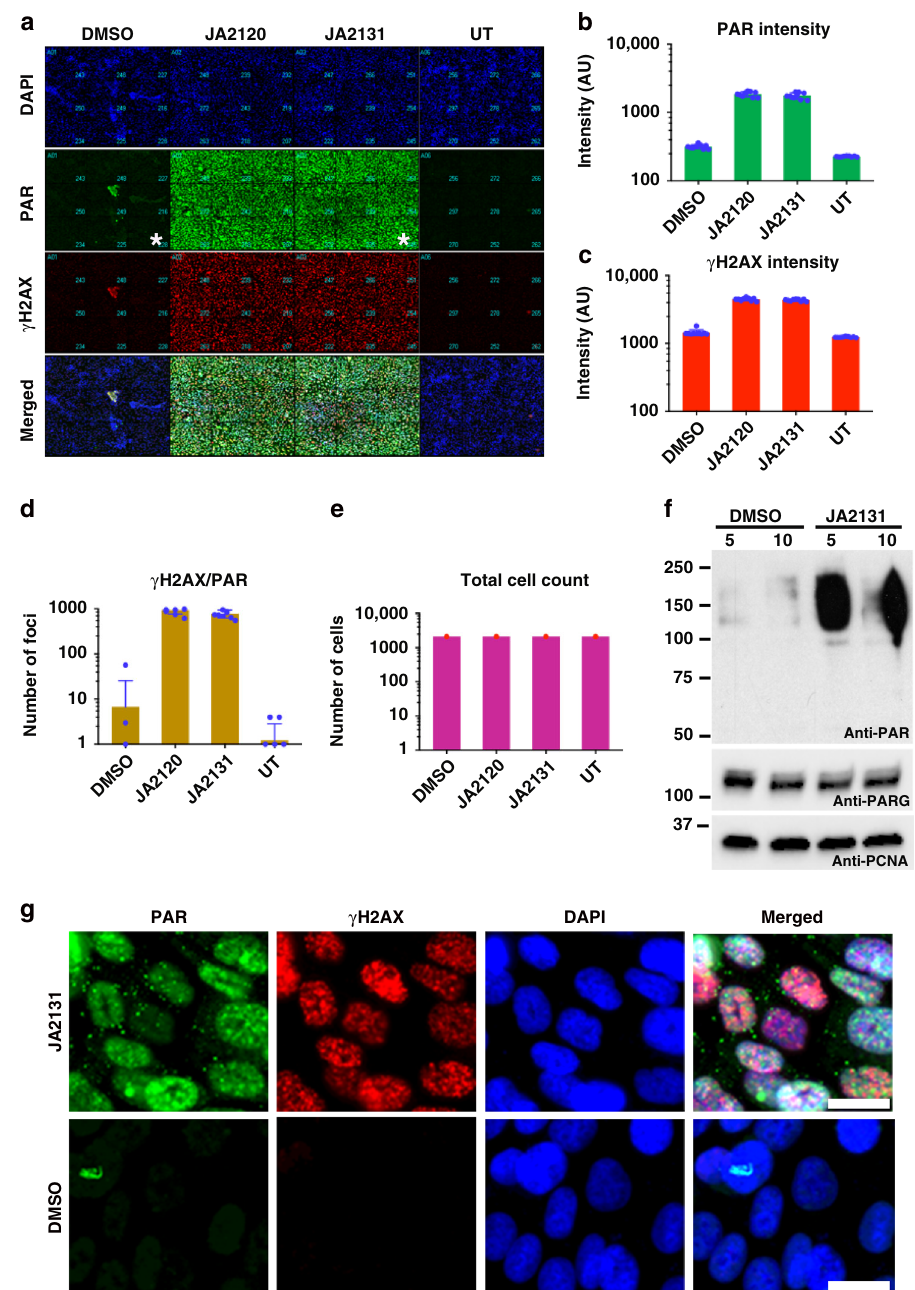
Fig. 5 PARGi sensitizes cells to IR damage. a High level of PAR accumulation and γ H2AX foci formation in cells exposed to PARGi. PC3 cells treated with DMSO or PARG inhibitors (JA2120 or JA2131) for 2h, irradiated with 7Gy, recovered for 1h were fi xed and immuno-stained with Poly(ADP)-Ribose (PAR, green) and γ H2AX (red) antibodies, nucleus stained with Hoechst (blue). Cells were analyzed with quantitative high-content imaging ( b – e ). Quantitative analysis of PAR intensity ( b ), γ H2AX intensities ( c ), the number of cells showing PAR / γ H2AX co-localizations ( d ), and nucleus count for the total number of cells analyzed for each group ( e ). f Immunoblotting of PARGi JA2131-treated PC3 cells showing inhibitor-induced cellular PARylation. Cells were treated with JA2131 for 2h followed by 7Gy IR, then allowed to recover for 1h before lysis. Total cell lysates were immunoblotted with anti-PAR (upper panel) followed by anti-PARG (middle panel) and Anti-PCNA (lower panel) as loading controls. g Enlarged, individual, representative images taken from one quadrant of the 3×(3×3) square shown in a and the region marked with an asterisk. This represents the quality of the image used to perform quanti fi cation for foci and colocalization calculations. Anti-PAR (green), Anti- γ H2AX (red) and Hoechst 33342 (blue). Scale bar 25 μ m. Note that the image contrast was quantitatively controlled and equal for both sets of data, see Supplementary Fig. 6 for independently contrast-adjusted images. Source Data are provided as a Source Data fi